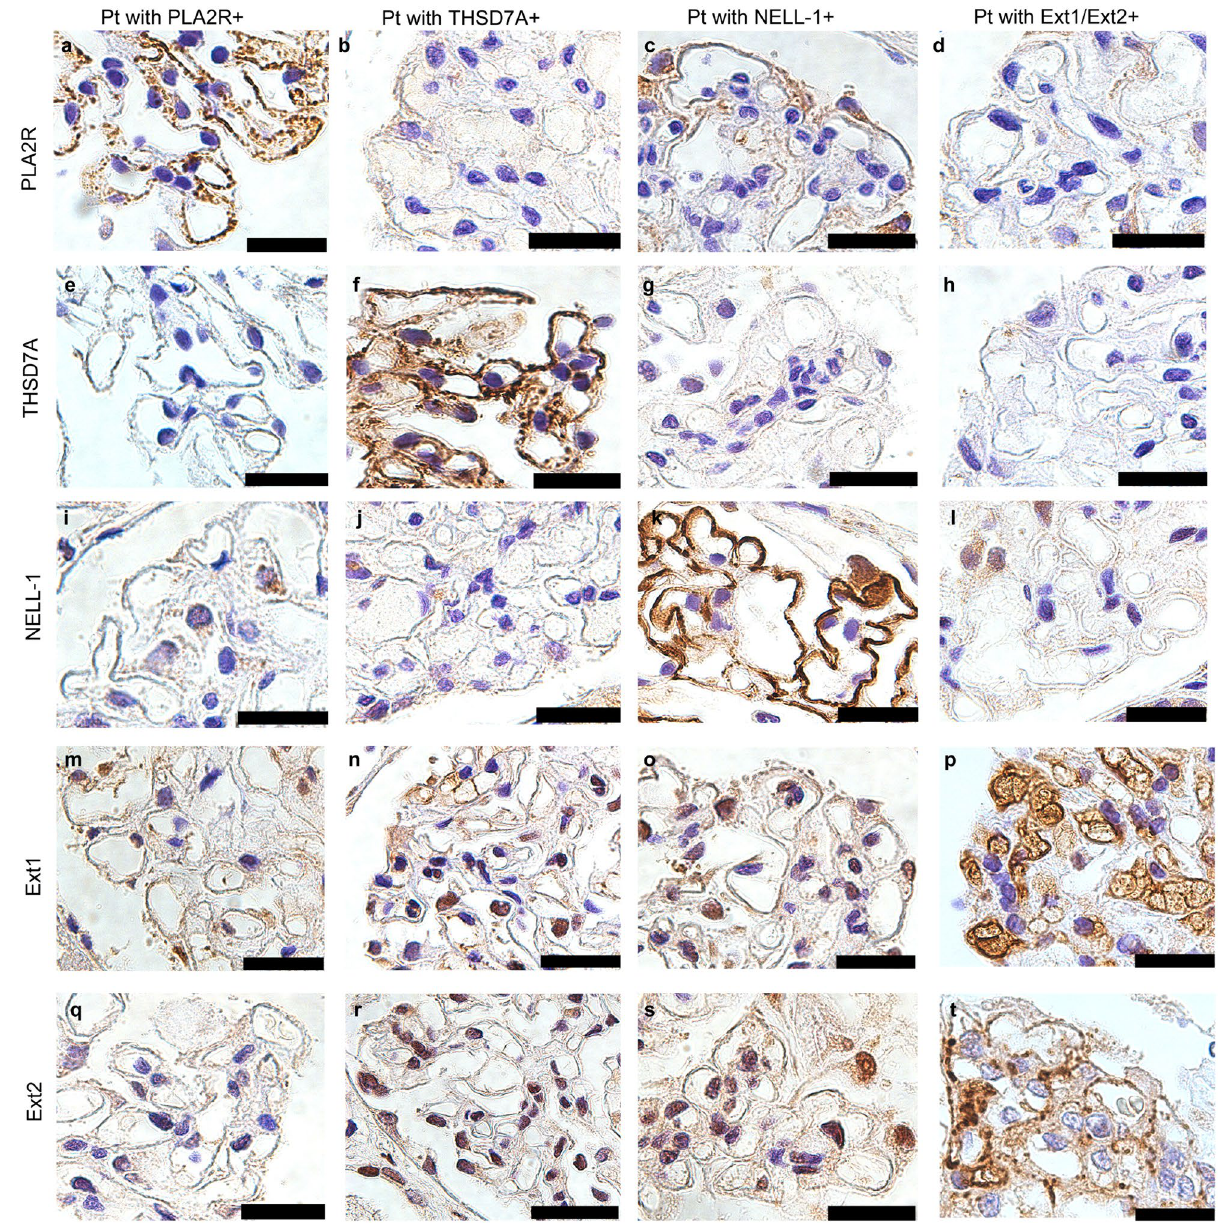
Figure 3. Immunohistochemical analysis for Phospholipase A2 receptor (PLA2R), Thrombospondin type-1 domain-containing 7A (THSD7A), Neural epidermal growth factor-like 1 protein (NELL-1), Exostosin (Ext) 1 and Ext2. Representative cases of immunostaining of PLA2R ( a – d ), THSD7A ( e – h ), NELL-1 ( i – l ), Ext1 ( m – p ) and Ext2 ( q – t ) in patients with primary membranous nephropathy. Original magnification: ×1000. Scar bar 25 μm. Pt